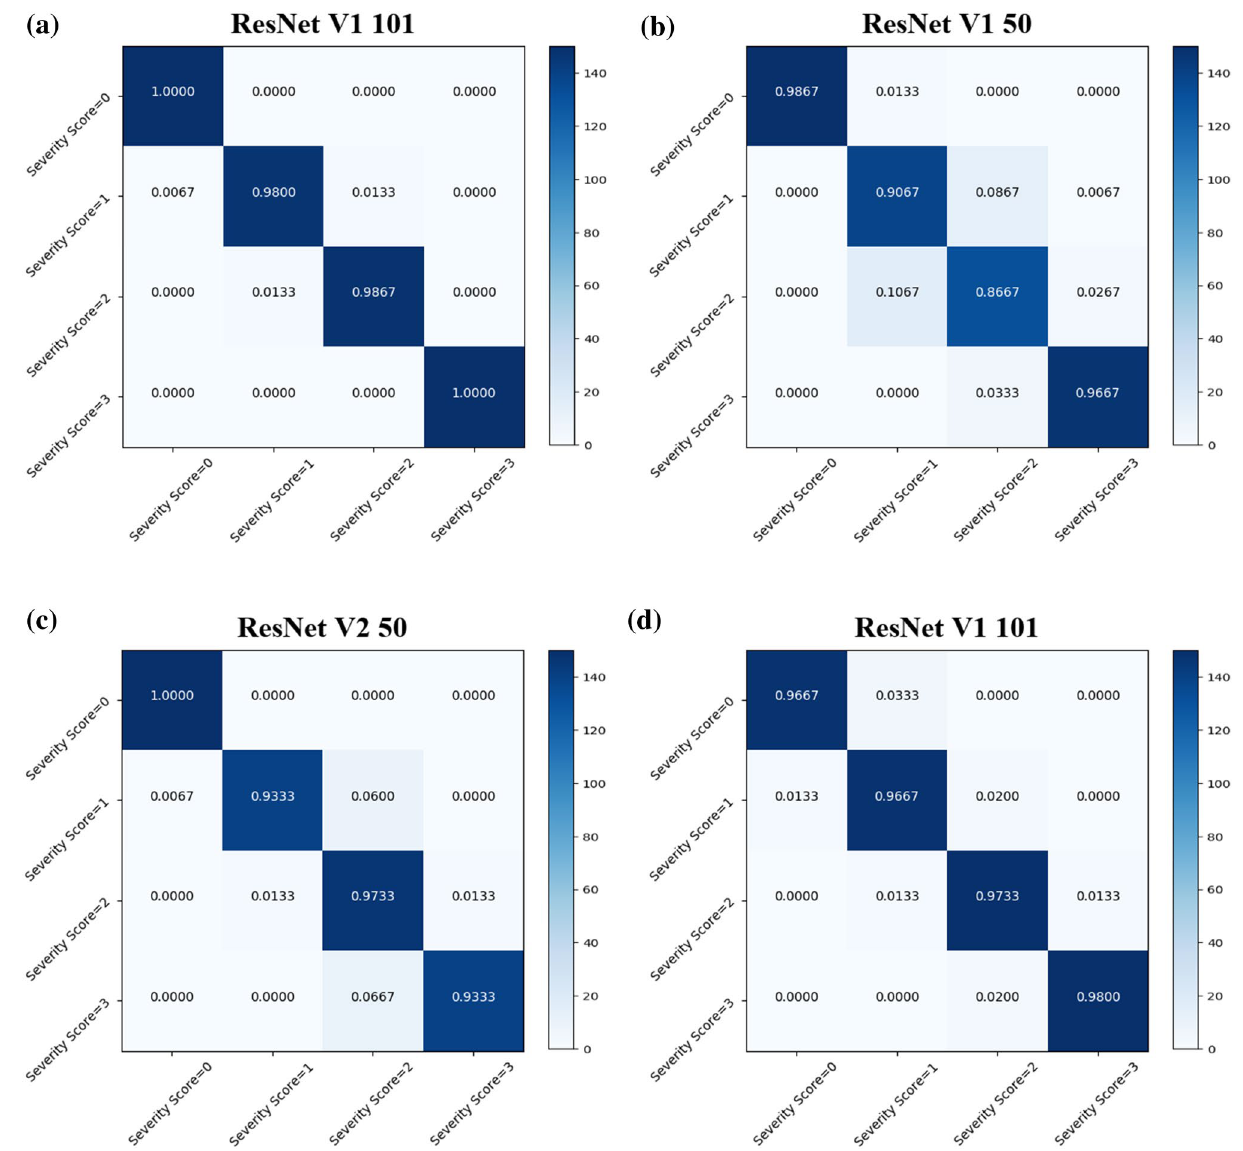
Figure 3. The most accurate CNN confusion matrices for ( a ) erythema, ( b ) induration/papulation, ( c ) excoriation and ( d )